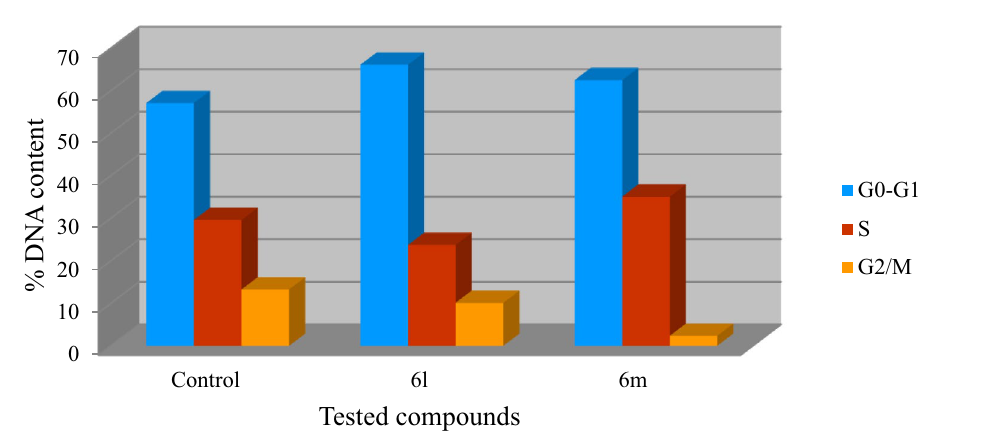
Figure 7. % DNA content of compounds 6l , 6m and control experiment for MCF7 (breast cancer cell line) at G0-G1, S and G2/M phases through PI-FC cell cycle